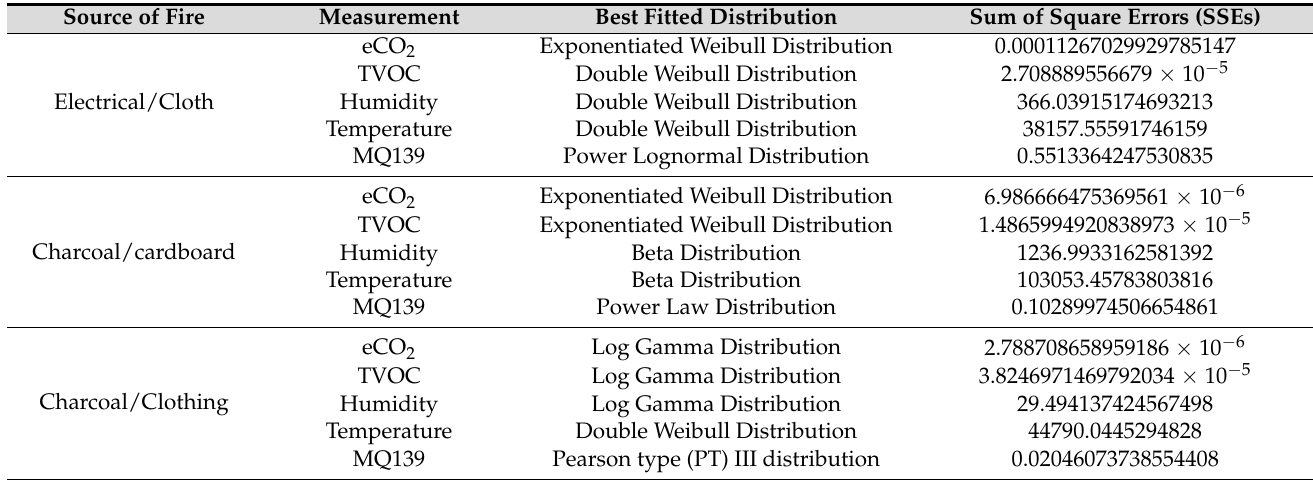
Table 2. For all reading measurements in each fire source (i.e., electrical/cloth, charcoal/cardboards, and charcoal/cloth, we found the best-fitted distributions, including their best